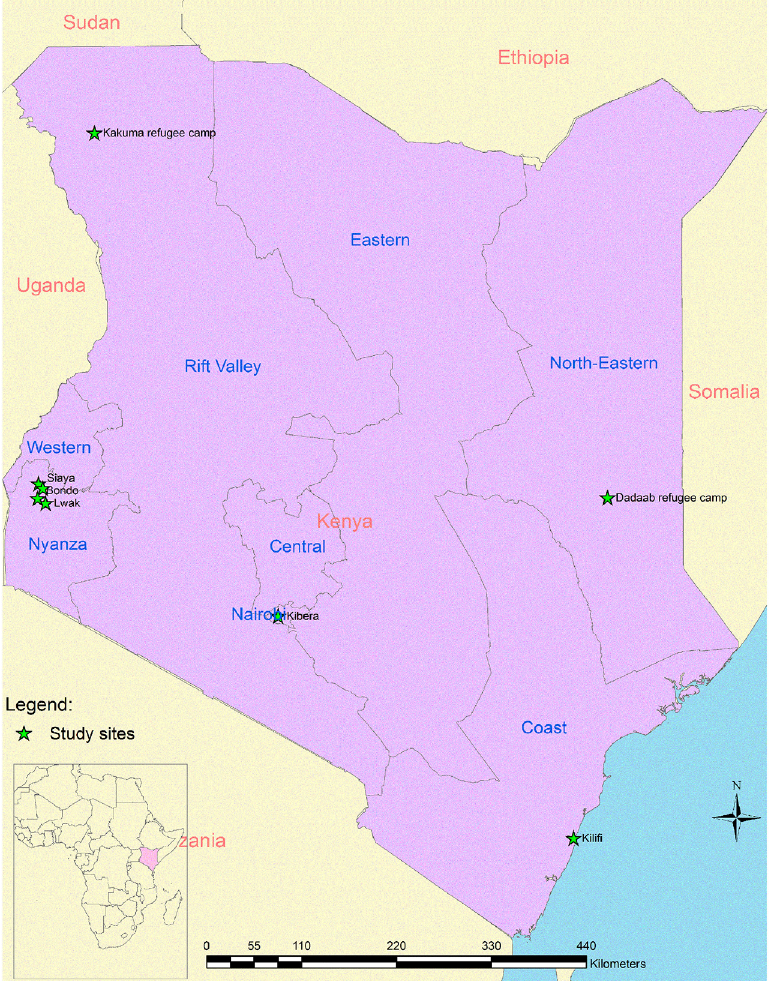
Fig 2. Map of Kenya showing the study sites which generated data that was used in the reviewed